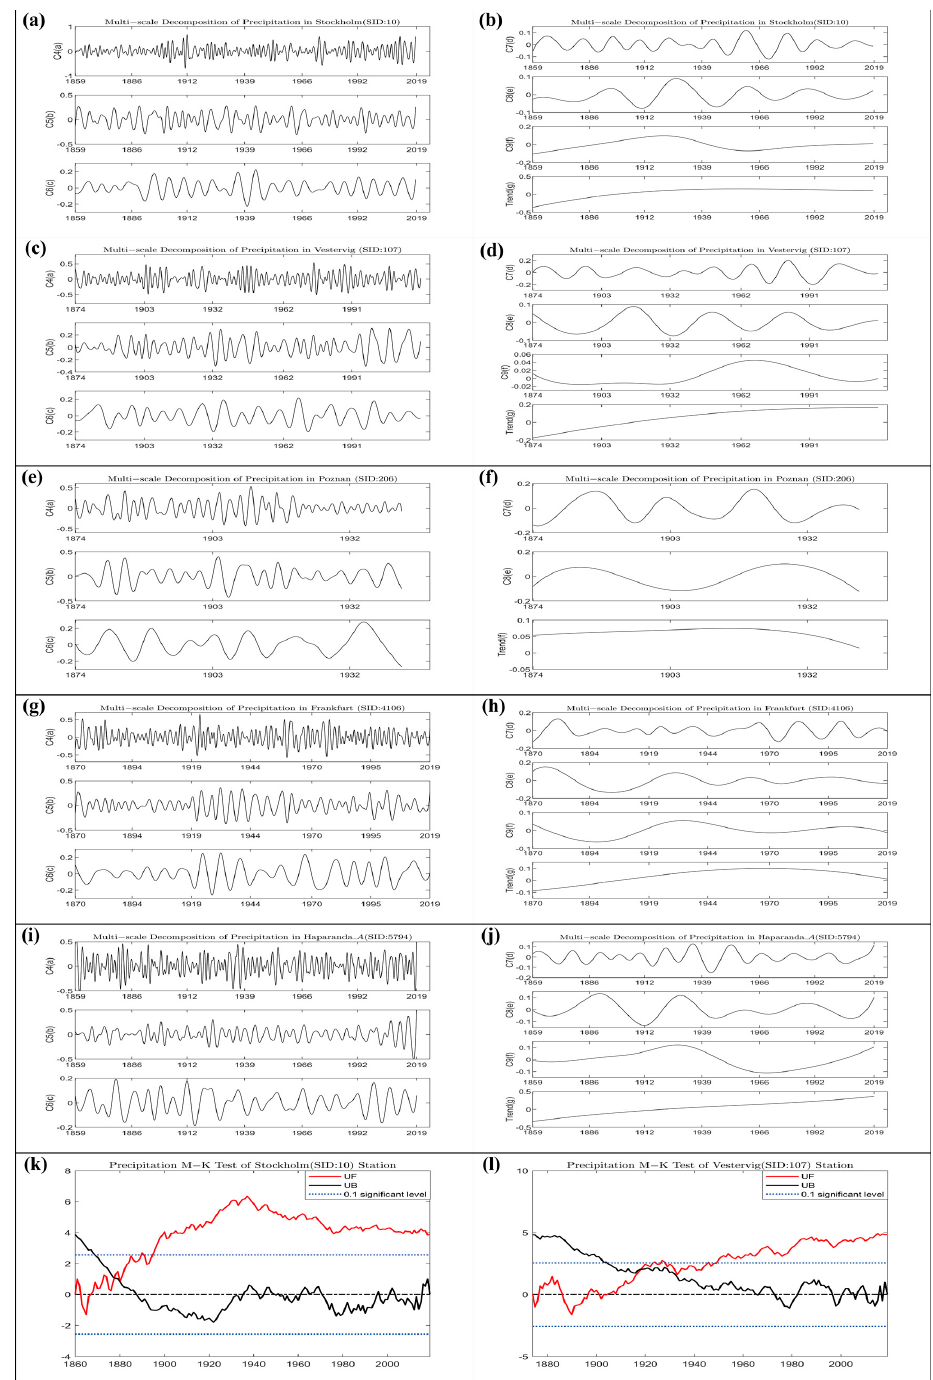
Figure 5. IMFs and trends of mean monthly precipitation in Stockholm station ( a , b ), Vestervig station ( c , d ), Poznan station ( e , f ), Frankfurt station ( g , h ), and Haparanda_A station ( i , j ); precipitation M-K test of Stockholm station ( k ) and Vestervig station ( l ). Table 5. Multi-scale periodic analysis of precipitation in areas around the Baltic Sea area (BSA).